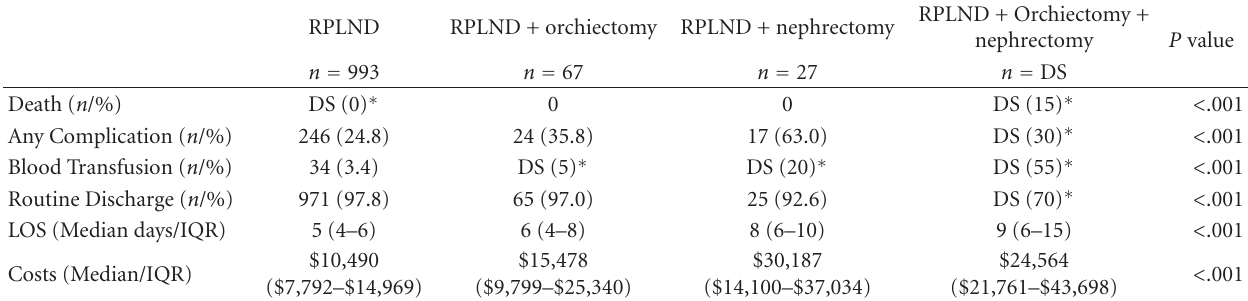
Table 5: Variation in RPLND complexity and